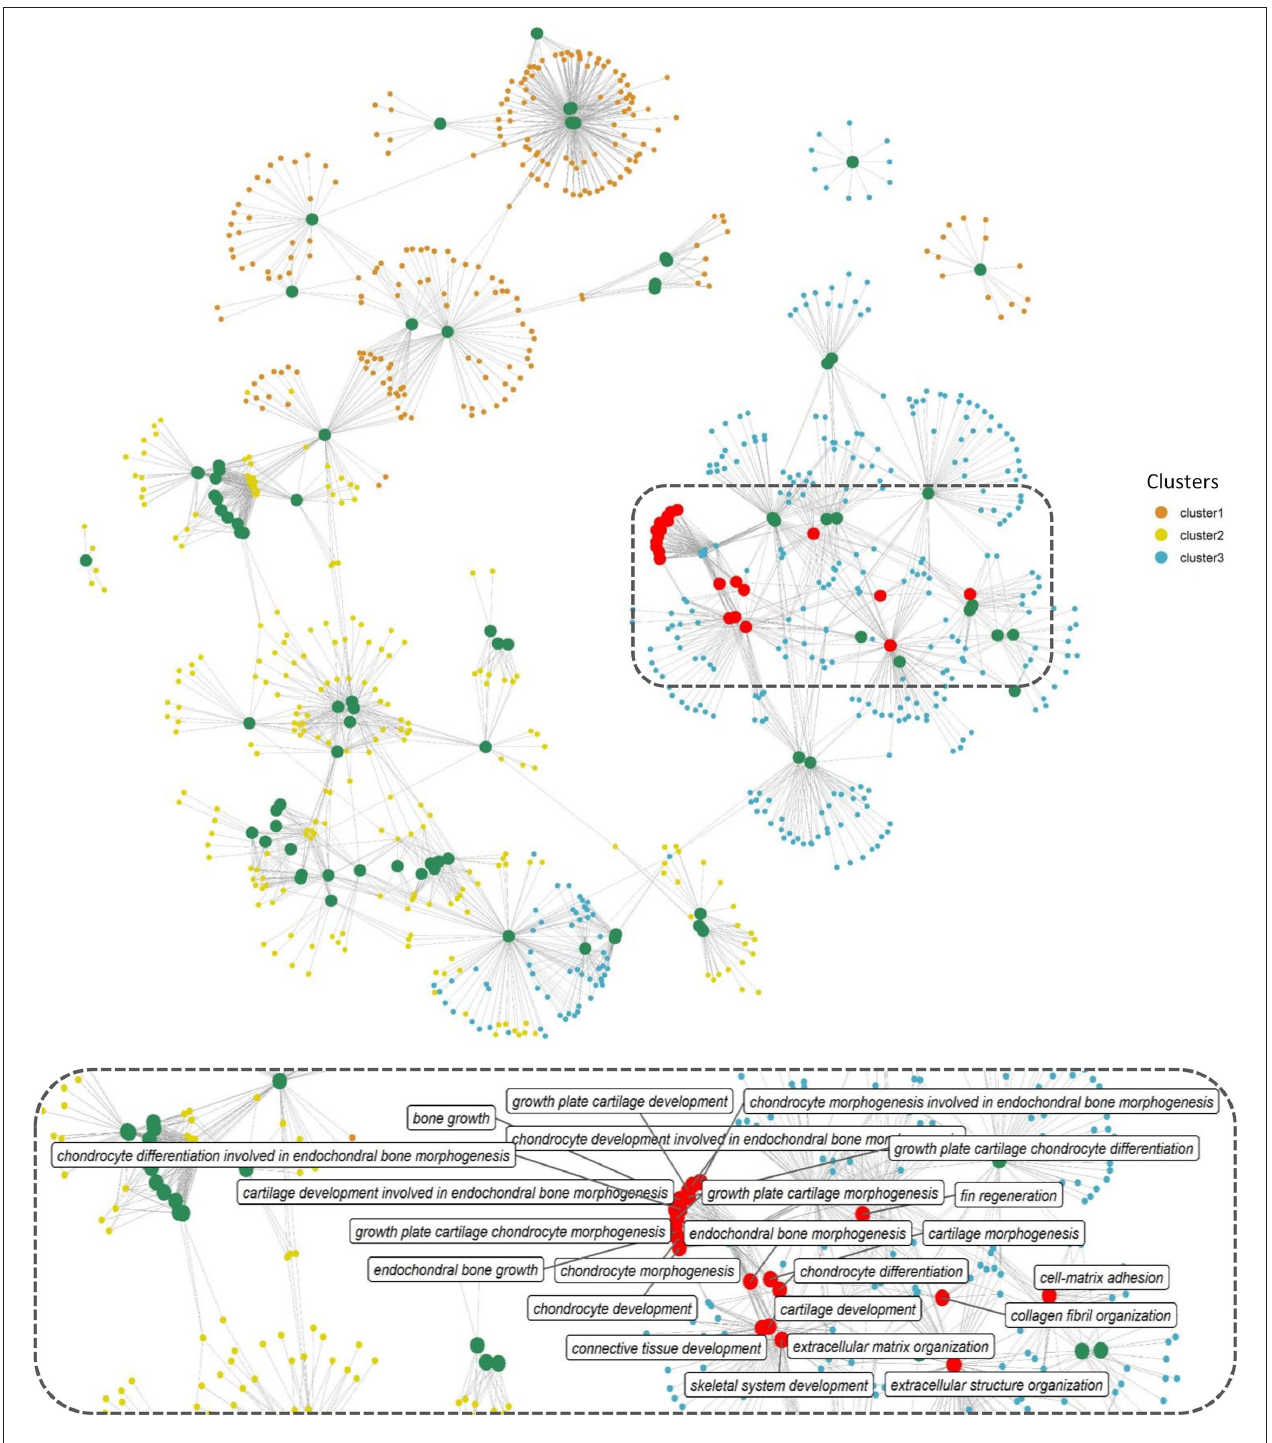
FIGURE 4 | Network representation of enriched GO terms (BP) performed against the DEGs across three different clusters ( Supplementary Table 4 ), the large-sized green and red-colored nodes indicate enriched GO terms, the red nodes in particular highlight GO terms in bone and skeleton system functioning, the region within the dashed rectangle is zoomed at the bottom of the network to highlight the nomenclature of key GO terms. Each small node of orange, green, and blue colors indicates a gene contributing to the enriched GO term across different clusters.